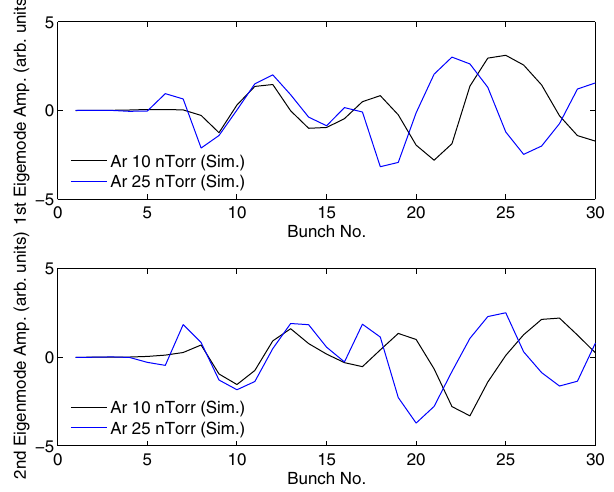
FIG. 8. Top two spatial eigenmodes (spatial eigenmodes being a representation of ion oscillations) at different pressures, as predicted by